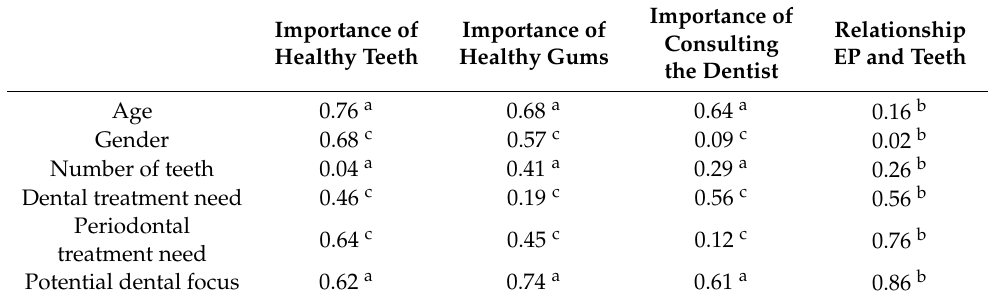
Table 3. Cross-sectional study ( n = 122): p -values for the associations between PRISM results and age, gender, as well as oral health